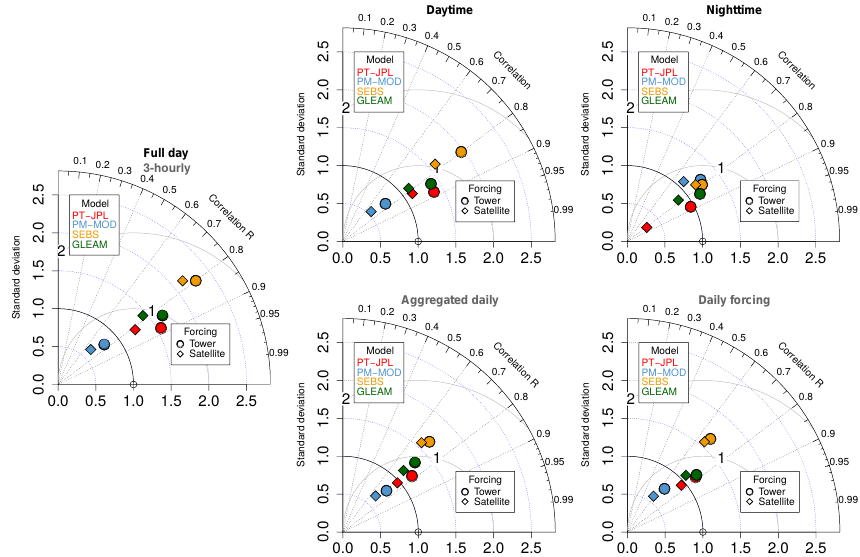
Figure 5. Taylor diagrams of 3-hourly model performance against EC reference in sub-daily periods (top-row panels) and as function of temporal resolution (bottom-row panels). The left panel shows the average model statistics for full-day (compare to top row) and 3-hourly output data (compare to bottom row). Daytime is defined as cases when the cosine of the sun elevation azimuth is > 0.2; nighttime is defined as cases when the cosine of the sun elevation azimuth is < 0.2. Shown are the normalized standard deviation, the normalized RMSD and the correlation coefficient ( R ).